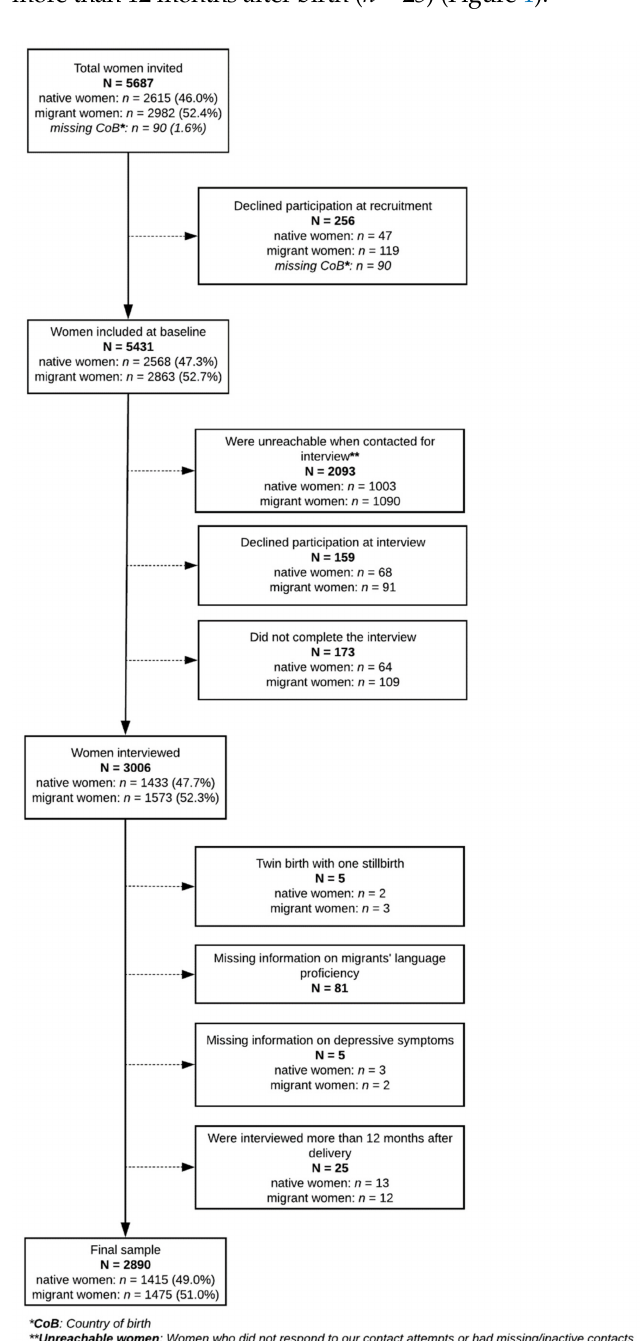
Figure 1. Flowchart of participation throughout the baMBINO study,